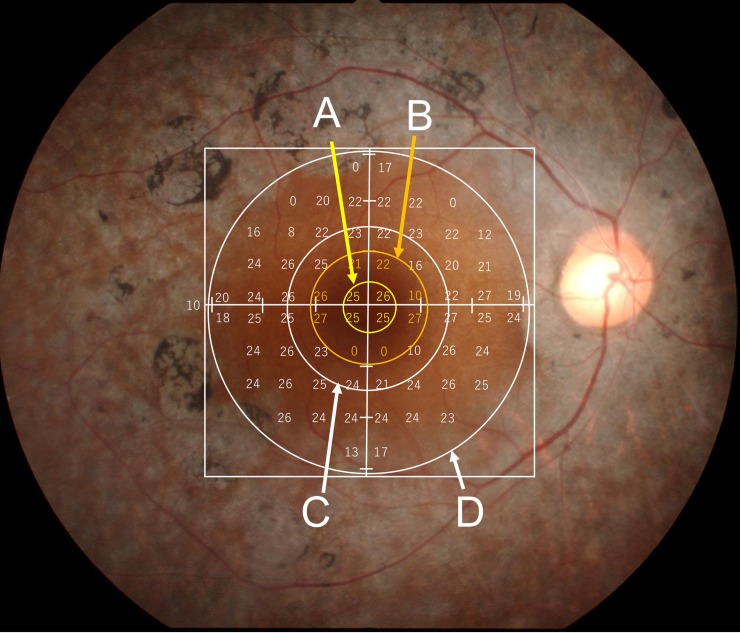
Fundus picture of a patient with RP overlaid by the same patient’s 10–2 plots of HFA and circles with radii of 1.0 mm (A), 2.2 mm (B), 3.0 mm (C) and 6.0 mm (D). An outermost squire is the macular cube (6 × 6 mm) of SD-OCT.